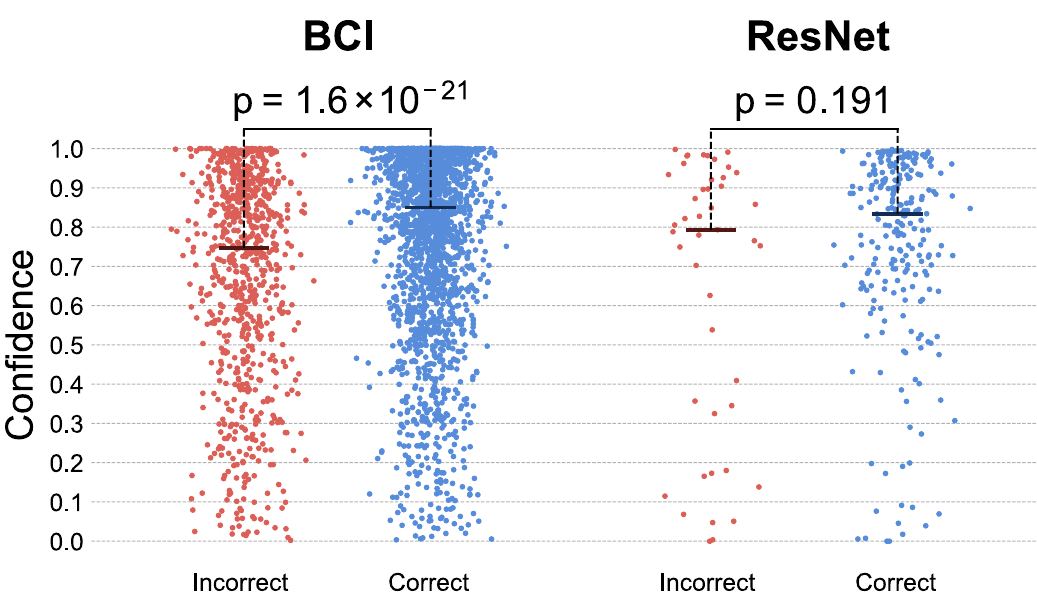
Fig 6. Distribution of confidence values for incorrect and correct decisions for the BCI (left) and the ResNet (right). Black lines indicate median values of each set. The p values of a Kruskal-Wallis test comparing the correct and incorrect distributions are also